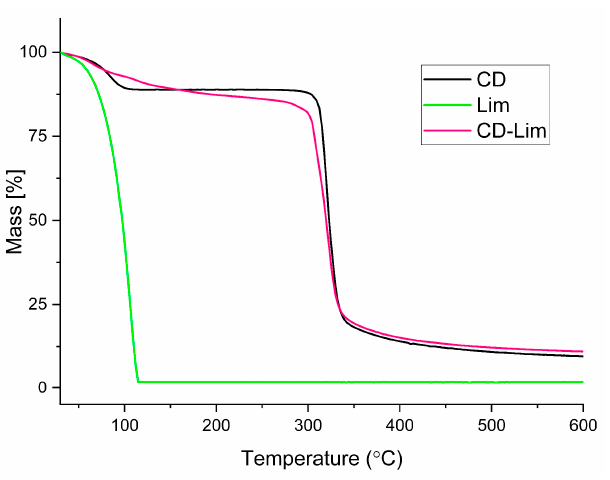
Figure 1. Thermogravimetric plots of β -cyclodextrin (black curve), D -limonene (green curve), and β -cyclodextrin/ D -limonene inclusion complex (magenta curve), upon heating at 10 °C min − 1 in nitrogen.